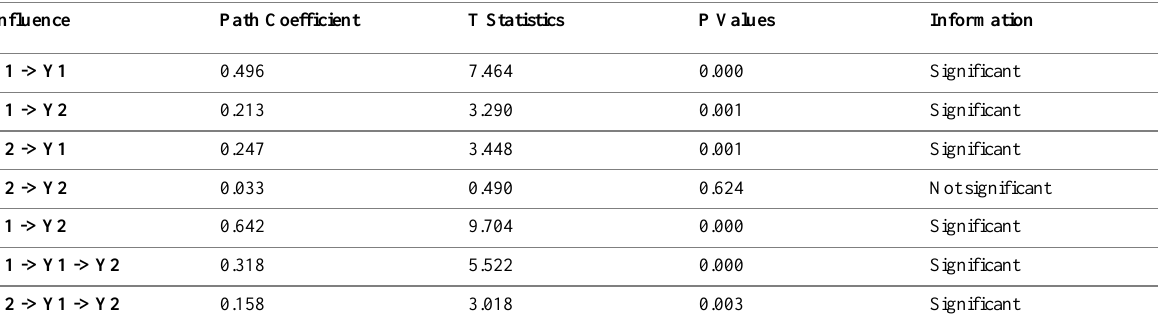
Table 4: Hypothesis Testing Results